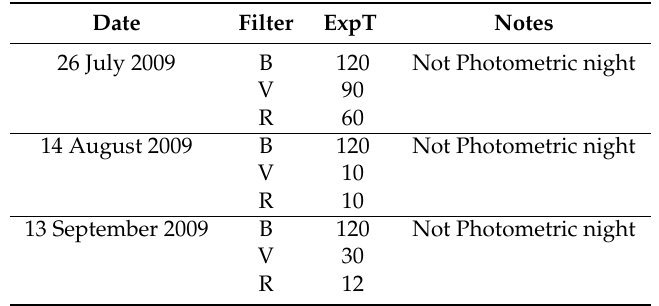
Table 2. Photometric observations of the blazar 3C 454.3 at four epochs in 2009. The table shows the observation date, filter, the exposure time (ExpT), and notes about the